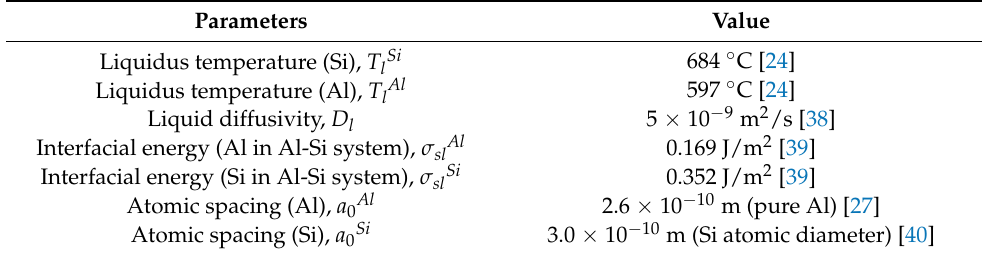
Table 3. Parameters used for nucleation rate